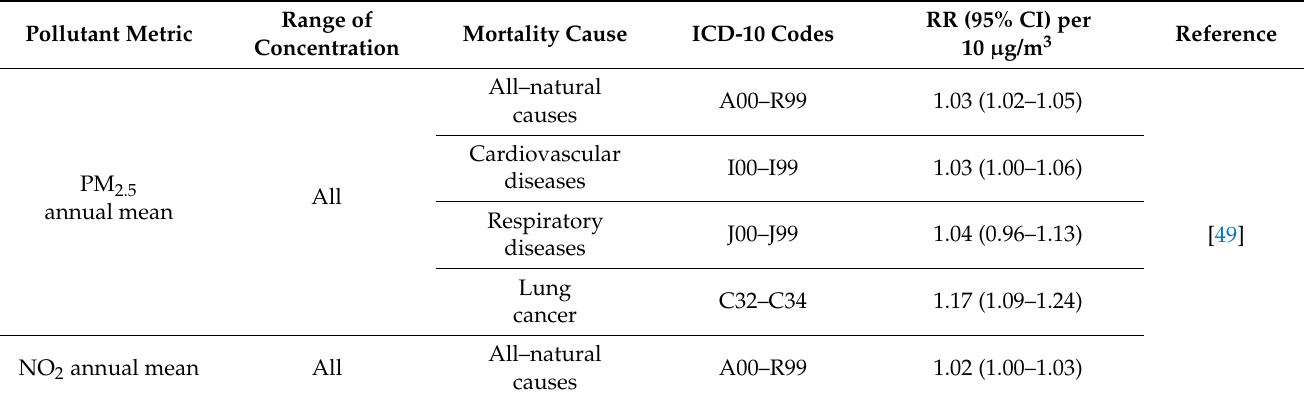
Table 3. Relative risks—alternative exposure assessment. Values are calculated for people aged more than 35